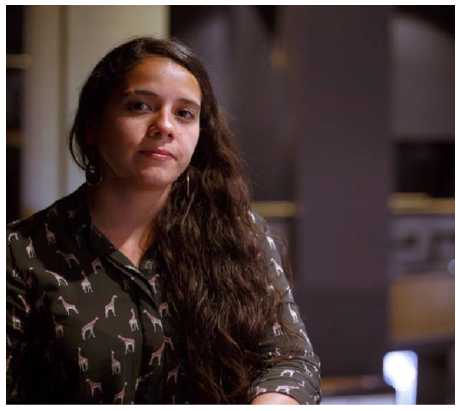
Figure 5. Director Lissette Orozco. Picture courtesy of Lissette Orozco.